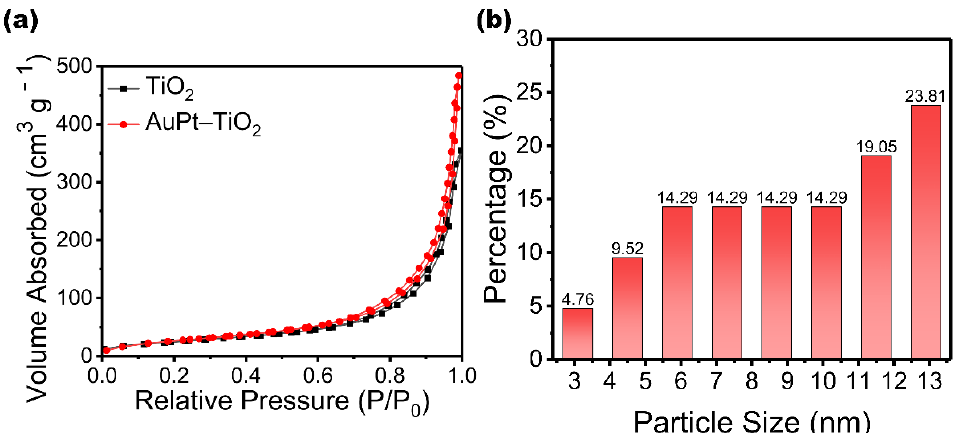
Figure 5. ( a ) N 2 adsorption – desorption isotherms and ( b ) particle size distribution of TiO 2 MSs and AuPt – TiO 2 .